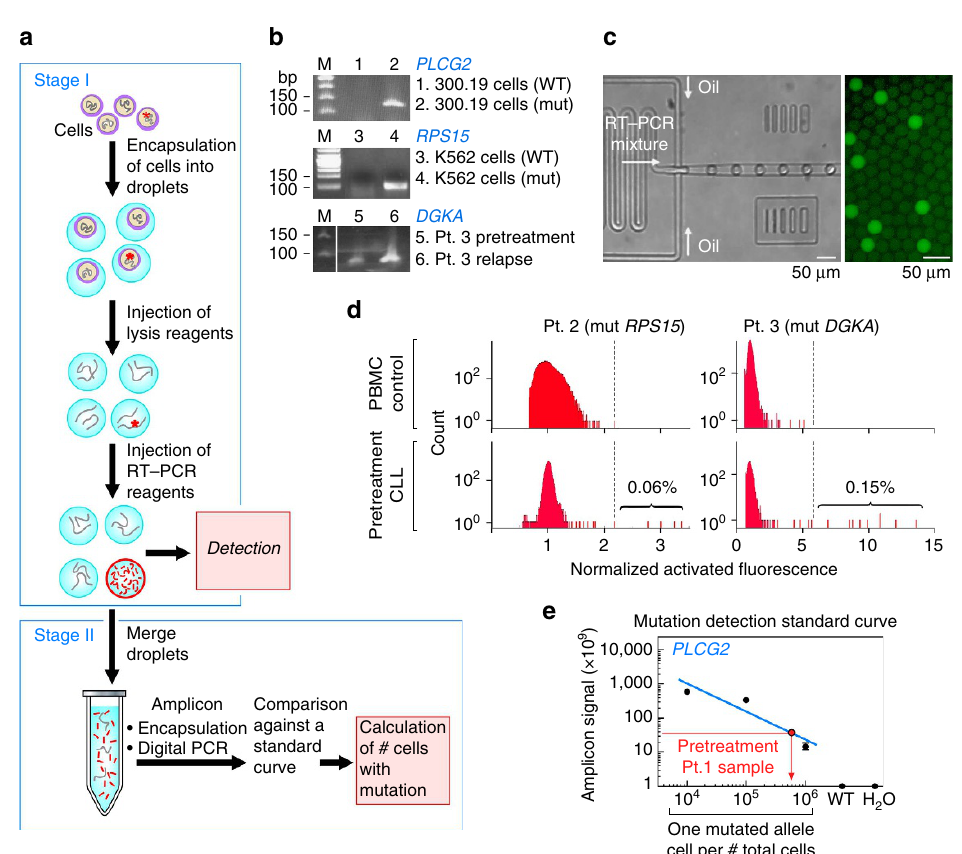
Figure 3 | Droplet-based detection of resistance subclones at the time of treatment initiation. ( a ) Schema of the experimental workflow. ( b ) Specificity of the mutation-detection primers visualized on an agarose gel in bulk cell line populations transfected to express minigenes encoding the WT versus mutated (MUT) allele (for PLCG2 and RPS15 ), or in bulk patient cDNA at pre-treatment and relapse time points (Patient 3, DGKA; c ). Droplet apparatus, and detection of bright droplets following amplification. ( d ) Detection of MUT RPS15 -specific single cells in Patient 2 samples and a PBMC control (left) and of MUT DGKA -specific single cells in Patient 3 samples and a PBMC control (right). ( e ) Standard curve for the detection of the PLCG2-M1141R template, established based on known input quantities on cell line (murine 30,019 cells, with error bars shown) expressing the MUT template, and detection of PLCG2-M1141R in the pre-treatment sample of Patient 1, but not in controls (Supplementary Fig. 4B).